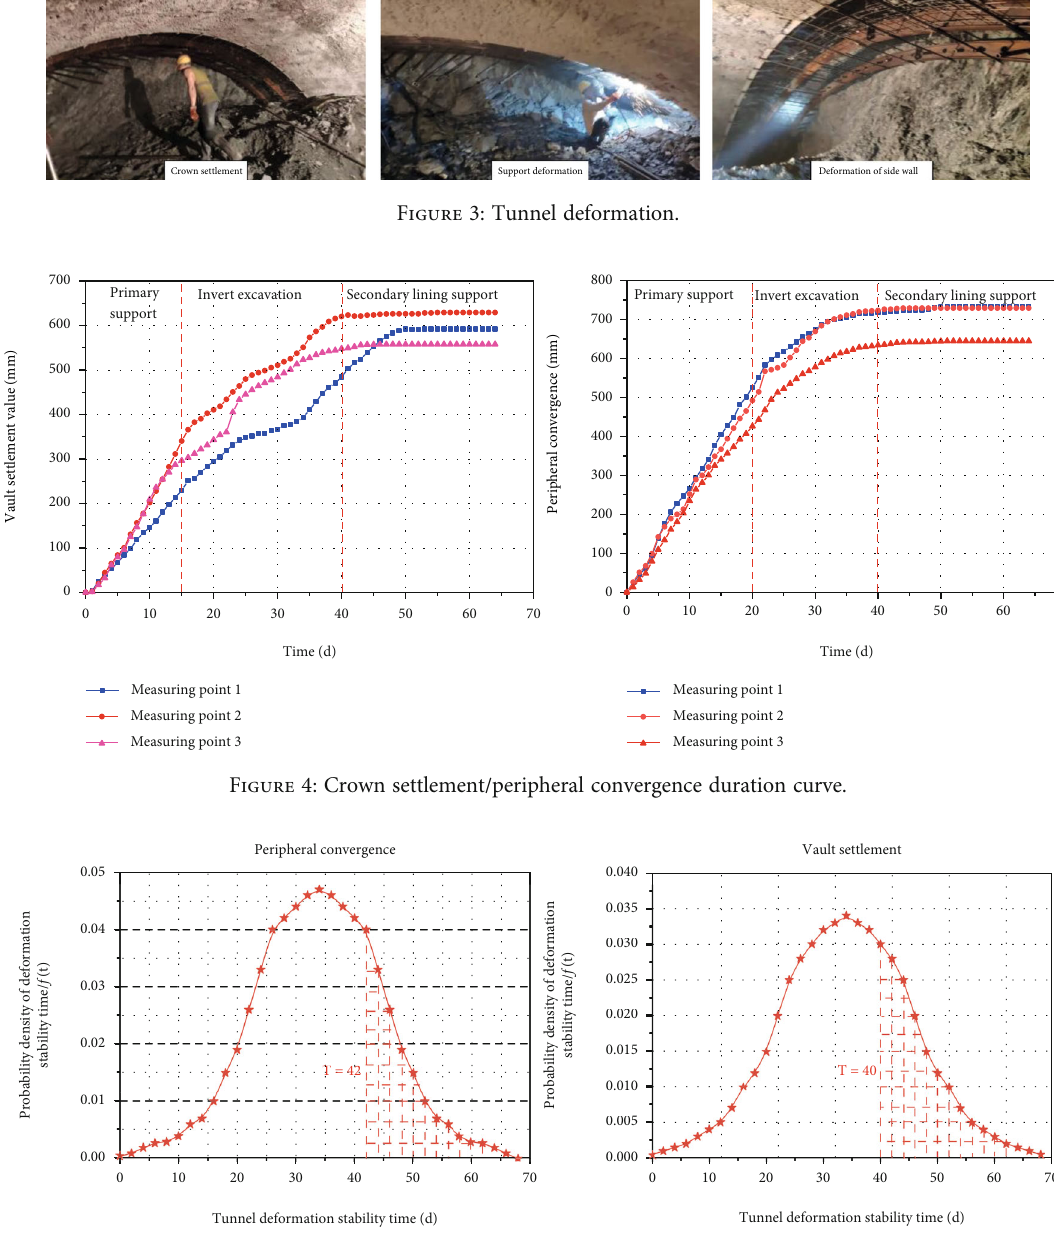
Figure 5: Normal distribution curve of vault settlement/peripheral convergence stability